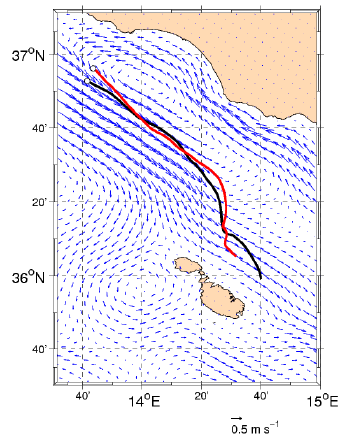
Figure 3. The 72-h long trajectories of two drifters, the red and the black lines starting from the white circle at north to the south, overlapped to the TSCRM current field averaged for the day of the release (October 29, 2017). Blue arrows indicate the surface current.